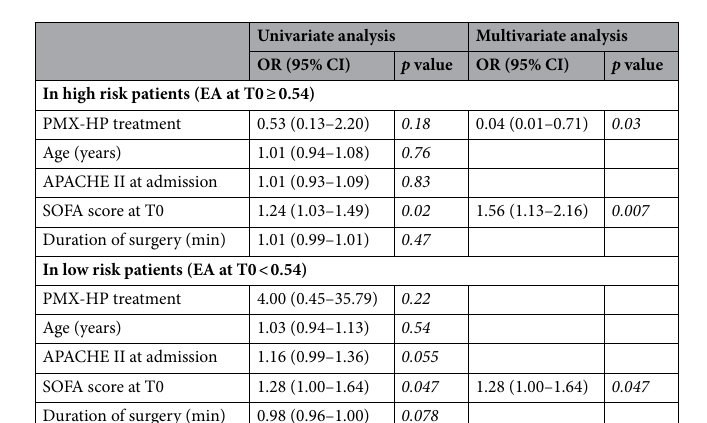
Table 2. Risk factor analysis for in-hospital death in high risk patients (EA ≥ 0.54 at T0) and in low risk patients (EA < 0.54 at T0). APACHE Acute physiology and Chronic Health Evaluation, CI confidence interval, EA Endotoxin activity, OR Odd ratio, PMX-HP Polymyxin B-hemoperfusion, SOFA Sequential Organ Failure Assessment. Significant values are in [italics].